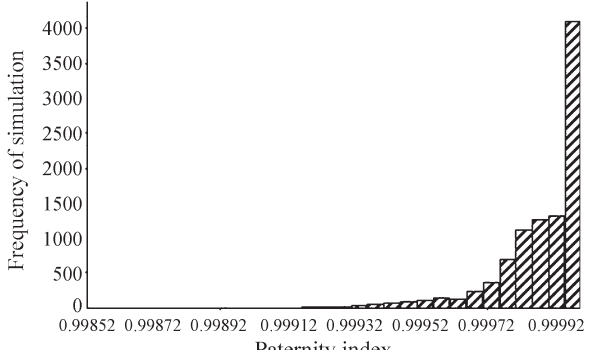
Figure 3 - Frequency distribution of 10000 values for the paternity index of male the M01 male for both cubs simultaneously, considering the seven loci and taking into account uncertainty both in the genotype of the mother and the allele frequency